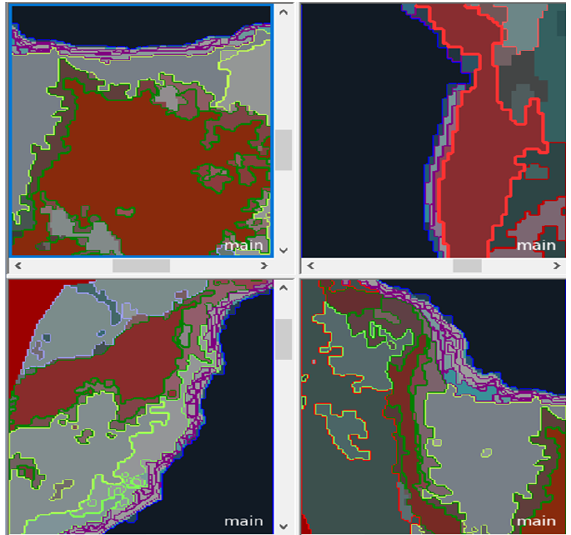
Figure 6: The state of Acacia forest patches clockwise from upper left corner: Southern part, North-Eastern part, Southern-Western part, & North-Western part of the study area where Acacia Forest patches (in red) existed before the onset of